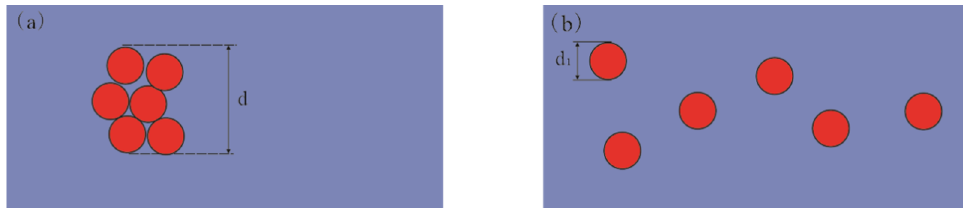
Figure 1. Hall–Petch effect for ( a ) coagulated nanoparticles and ( b ) well-ordered nanoparticles.